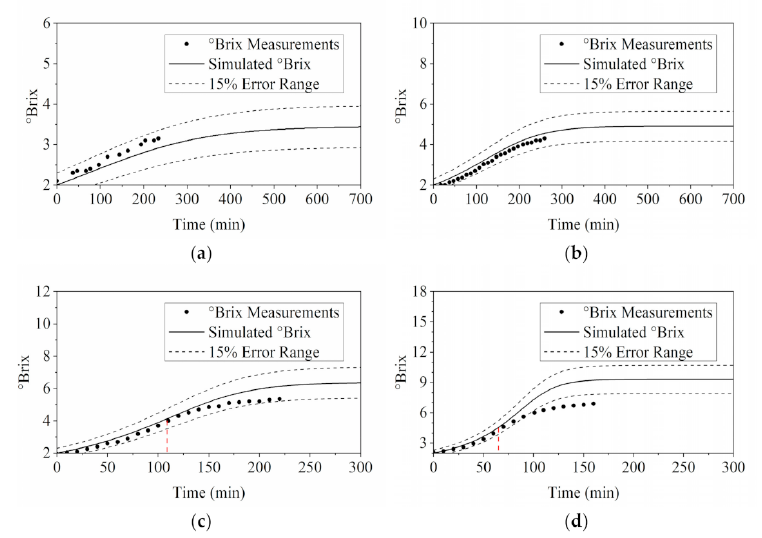
Figure 4. Validation of RO model via comparing the simulation results of ◦ Brix with the ◦ Brix measurements taken during the experiments with different operating pressures: ( a ) 0.3 MPa; ( b ) 0.45 MPa; ( c ) 0.6 MPa; and ( d ) 0.9